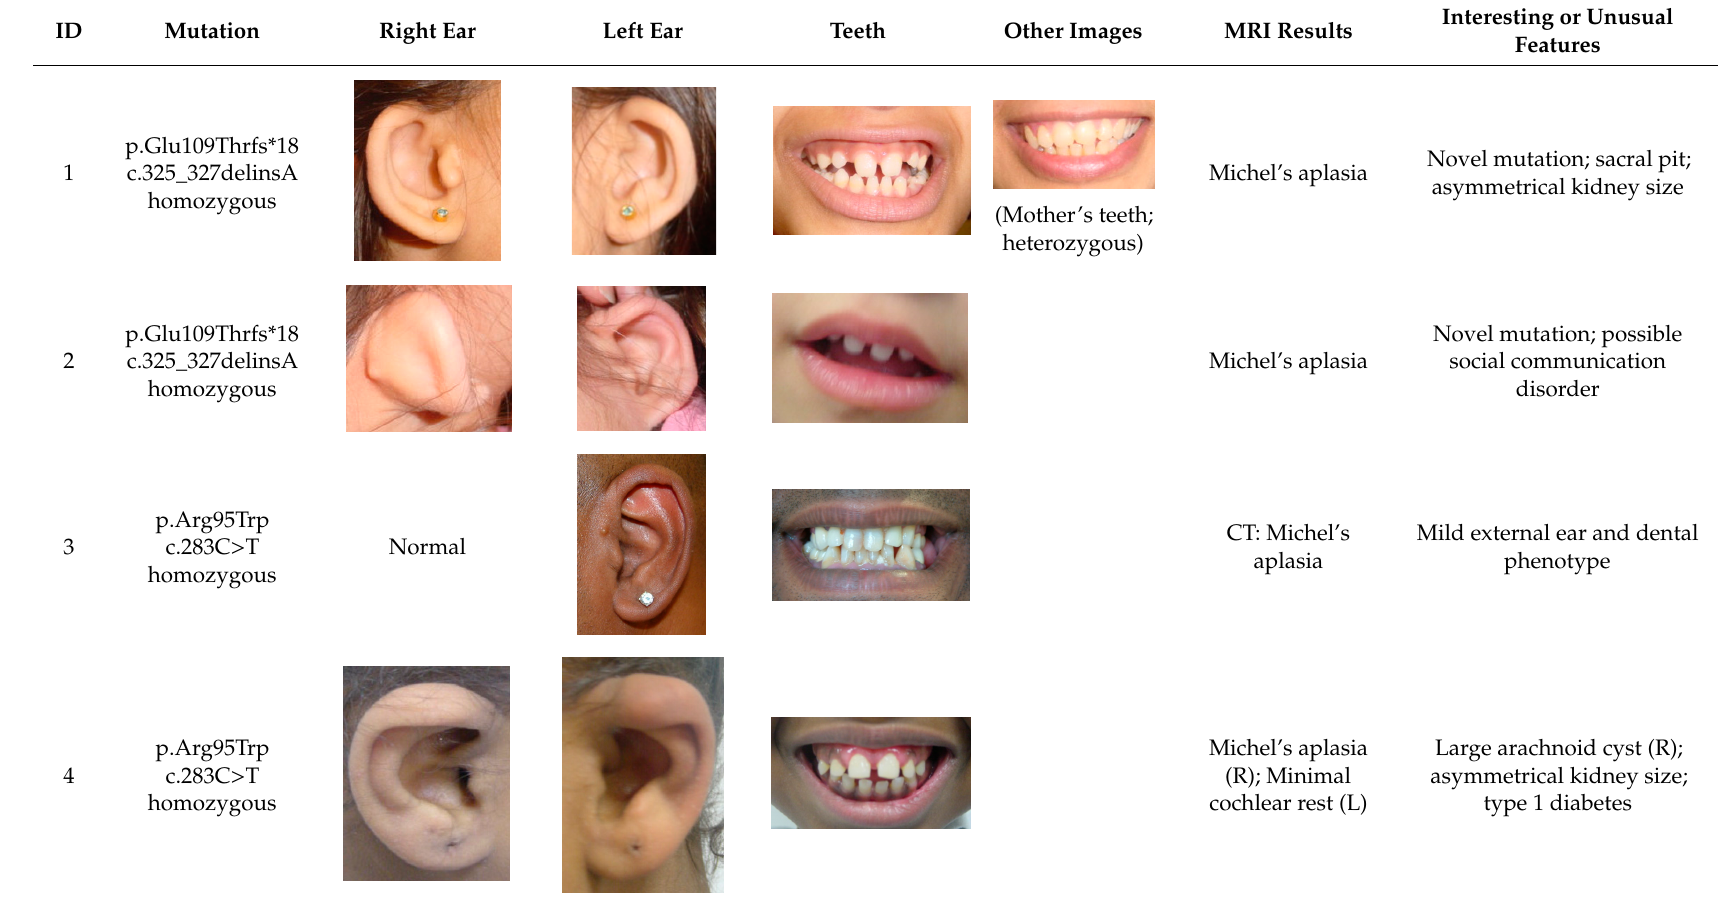
Table 1. Clinical details of the eight patients presented in this work.